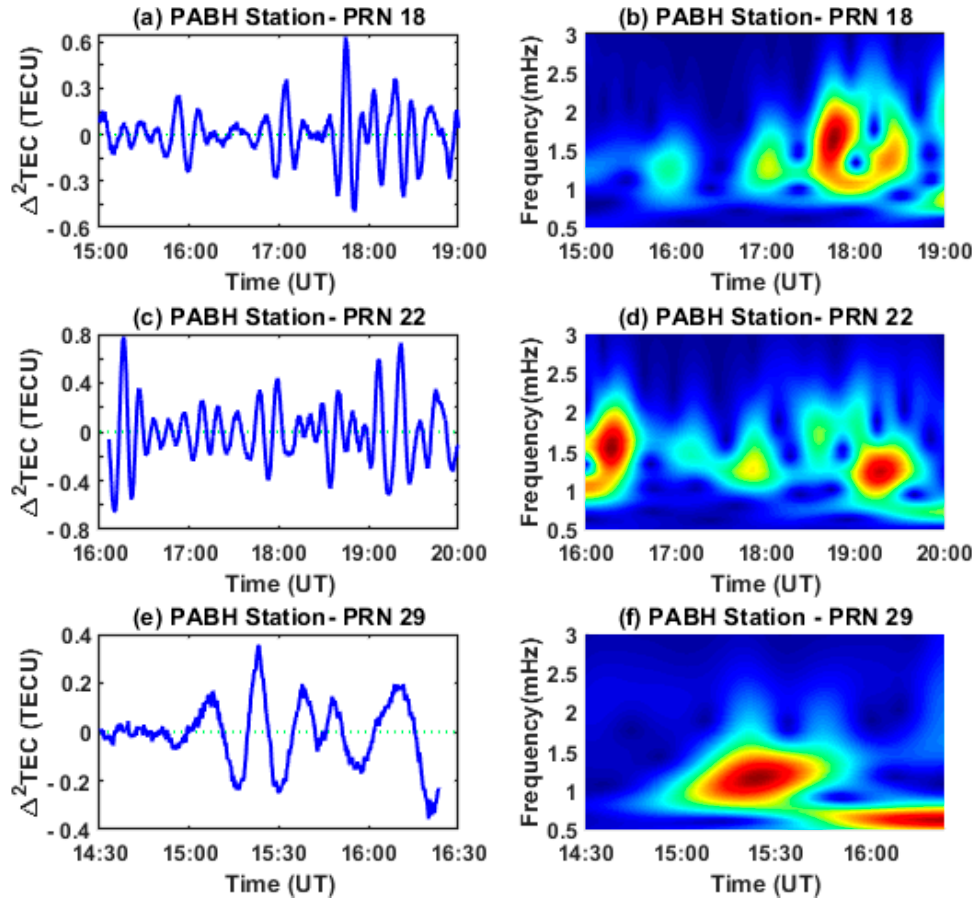
Figure 8 . Time series for PRN18 ( a ), PRN22 ( c ), and ( e ) PRN29 observed from GPS station PABH. ( b ), ( d ), and ( f ) the time-frequency analysis for the ∆ 2 TEC time series. Figures 9 and 10 show the ∆ 2 TEC time series of PRN18, PRN22, and PRN29 observed from the same stations from 14:30 UT to 21:00 UT on 10 March (a day before the tsunami) and 12 March (a day after the tsunami). There are no obvious disturbances in the ∆ 2 TEC time series on 10 and 12 March. The average values of ∆ 2 TEC between 15:10 UT and 20:00 UT (time of the propagation of IGWs to the ionosphere on 11 March) on the three days of March 10, 11, and 12 of 2011 were 0.01, 0.04, and 0.01 TECU, respectively.